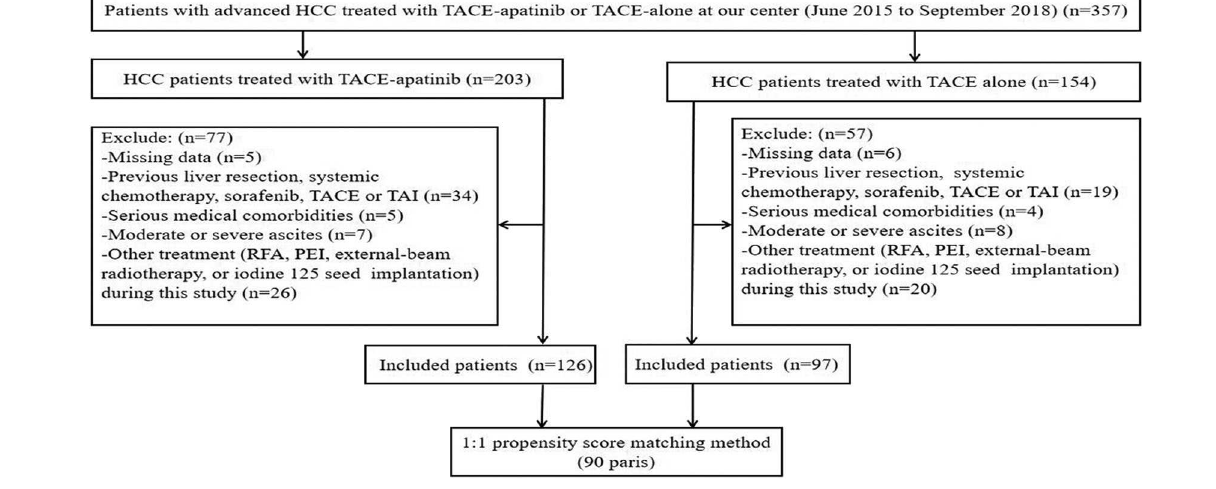
Frontiers in Oncology |